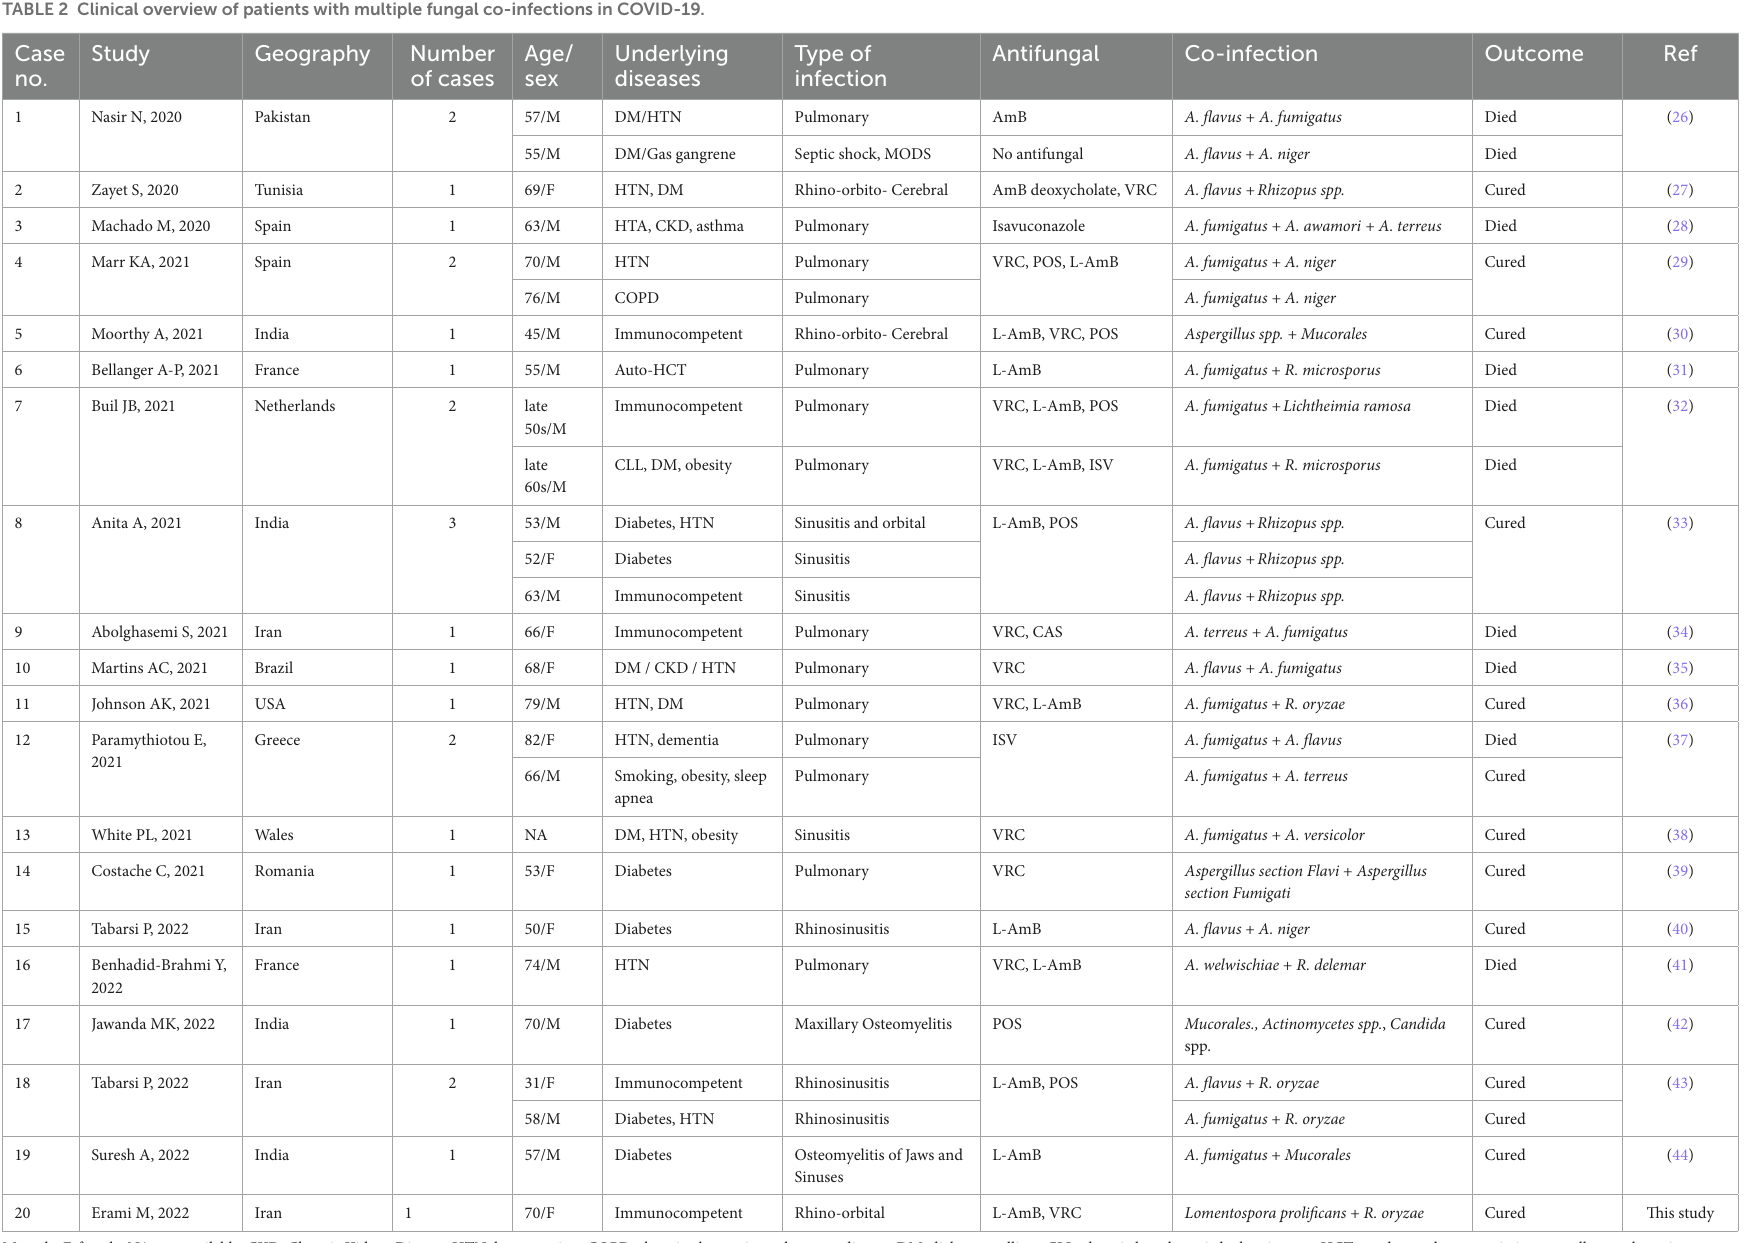
TABLE 2 Clinical overview of patients with multiple fungal co-infections in COVID-19. Case